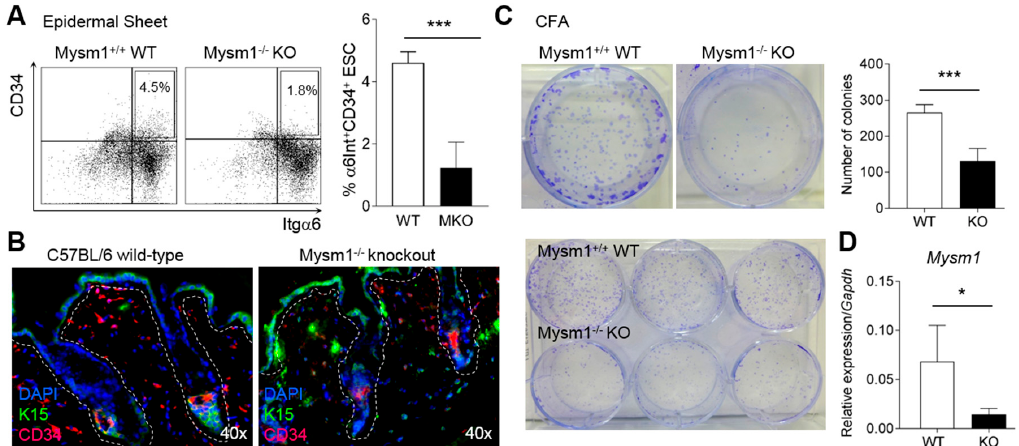
Figure 4. Mysm1-deficiency affects epidermal stem cells. ( A ) FACS-analysis of α 6-Integrin ( α 6Int) high+ CD34 + fractions in epidermal single cell suspensions prepared from 8-week-old Mysm1 − / − and wild-type mice (representative dot plots on the left and corresponding bar graphs of mean values on the right, n > 6); ( B ) IF analysis of K15 + CD34 + cells in skin cryosections prepared from 4-week-old Mysm1 − / − and wild-type mice (K15 in green, CD34 in red, DAPI-stained nuclei in blue, double-positive cells in yellow, n > 3, representative images shown, original magnification 40×); ( C ) Colony formation assay (CFA) under keratinocyte differentiation conditions with 4000 epidermal cells per well prepared from 8-week-old Mysm1 − / − mice and their wild-type littermates (images of representative wells on the right and statistical summary on the left, n > 4, 3 independent experiments); ( D ) Mysm1 mRNA expression in colonies from either wild-type or Mysm1 − / − progenitors relative to Gapdh .